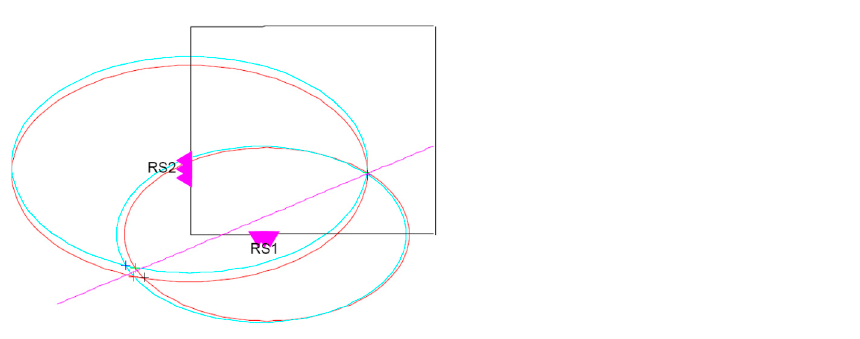
Figure 10. Optimal line guided by the intersections of ellipse RS1 and RS2 sets in the point τ = 100. The analog expression E 4 RS 2 represents ellipse No. 4 in radar set RS2, with foci in the position of the transmitter Tx B and in the position of the receiver Rx B2 . The line drawn through the intersections of the ellipses represents the 2nd line using the method of lines.